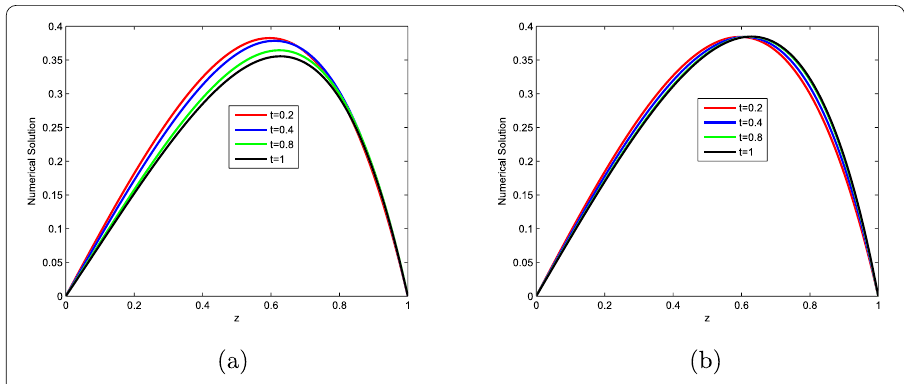
Figure 3 Numerical solution for N = 64, M = 40, ε = 2 –16 at different time levels: ( a ) Example 5.1, ( b ) Example 5.2